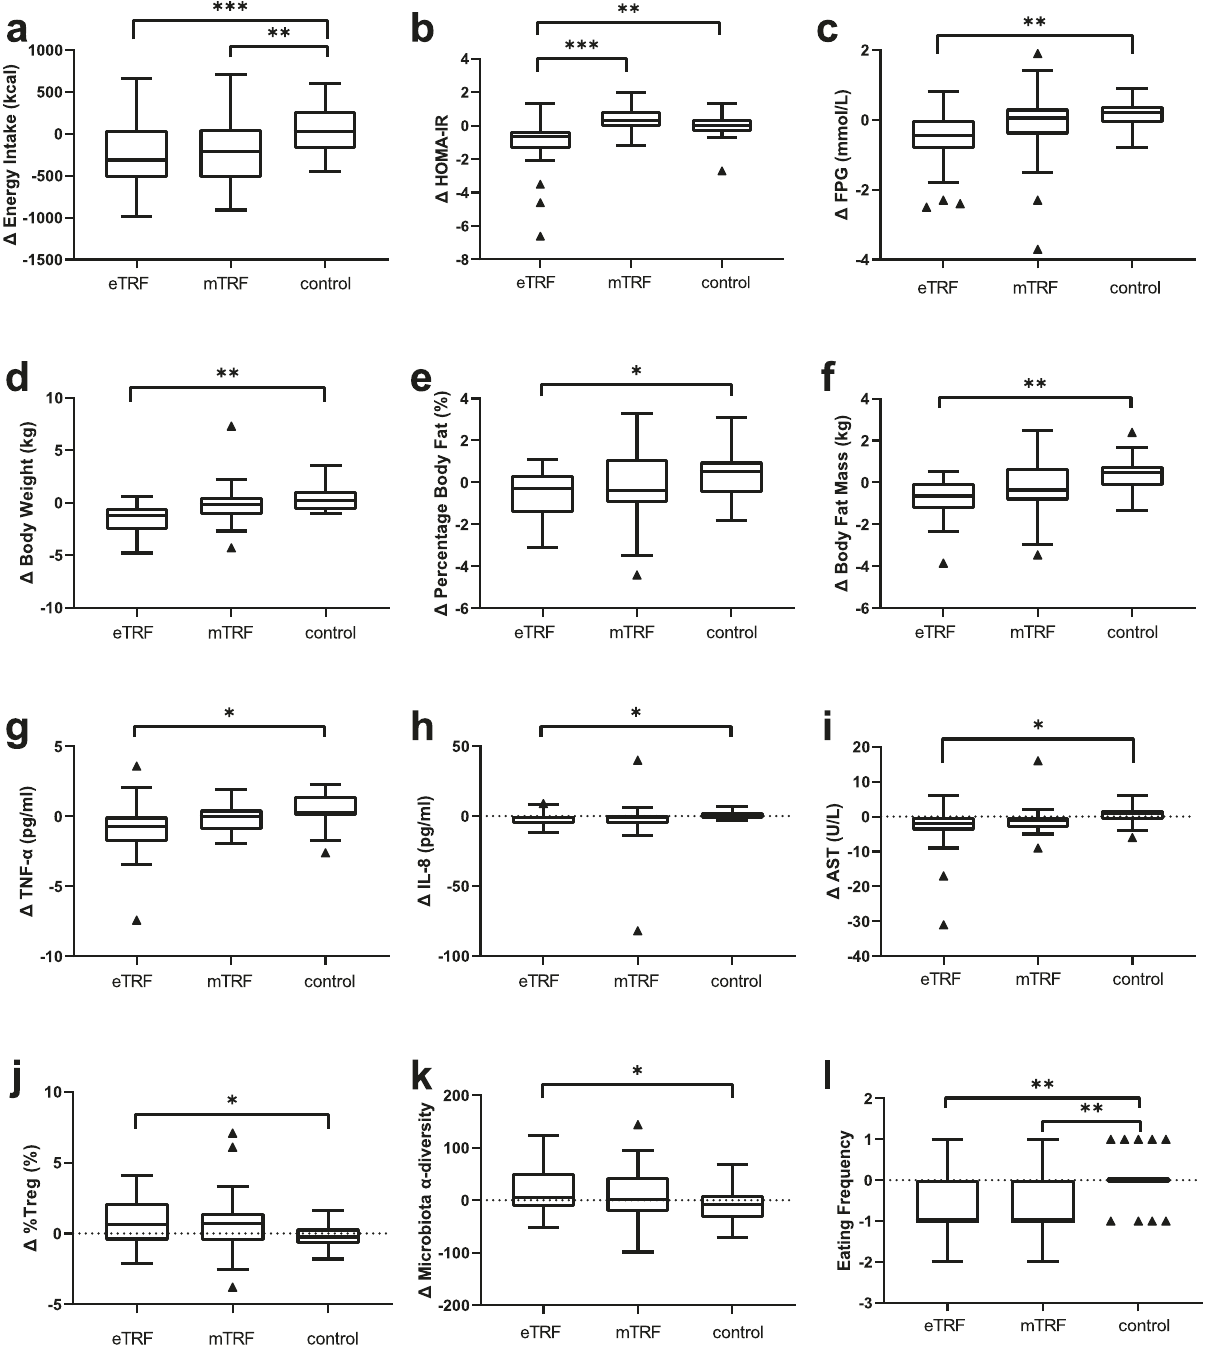
Fig. 2 Energy intake and metabolic health-related parameters. a Change in daily energy intake after 5 weeks of intervention, *** p < 0.001, ** p = 0.009. b Change in insulin resistance index (measured with HOMA-IR) after 5 weeks of intervention, *** p < 0.001, ** p = 0.002. c Change in fast plasma glucose (FPG) after 5 weeks of intervention, ** p = 0.005; d Change in body mass after 5 weeks of intervention, ** p = 0.009. e Change in percentage body fat after 5 weeks of intervention, * p = 0.042. f Change in body fat mass after 5 weeks of intervention, ** p = 0.001. g Change in TNF- α (tumor necrosis factor- α ) after 5 weeks of intervention, * p = 0.024. h Change in IL-8 (interleukin-8) after 5 weeks of intervention, * p = 0.045. i Change in AST (aspartate transaminase) after 5 weeks of intervention, * p = 0.046. j Change in plasma Tregs (T regulatory cells) after 5 weeks of intervention, * p = 0.038. k Change in gut microbiota α -diversity after 5 weeks of intervention, * p = 0.048. l Change in eating frequency after 5 weeks of intervention, ** p = 0.001. n = 28 participants in eTRF group, n = 26 participants in mTRF group, n = 28 participants in control group. Data is visualized as Tukey box plots (line at mean, top of the box at the 75th percentile, bottom of the box at the 25th percentile, whiskers at the highest and lowest values, outliers shown as triangles beyond the whiskers). * p < 0.05, ** p < 0.01, *** p < 0.001. One-way repeated measures ANOVA followed by Holm-Sidak ’ s multiple comparisons test for between group